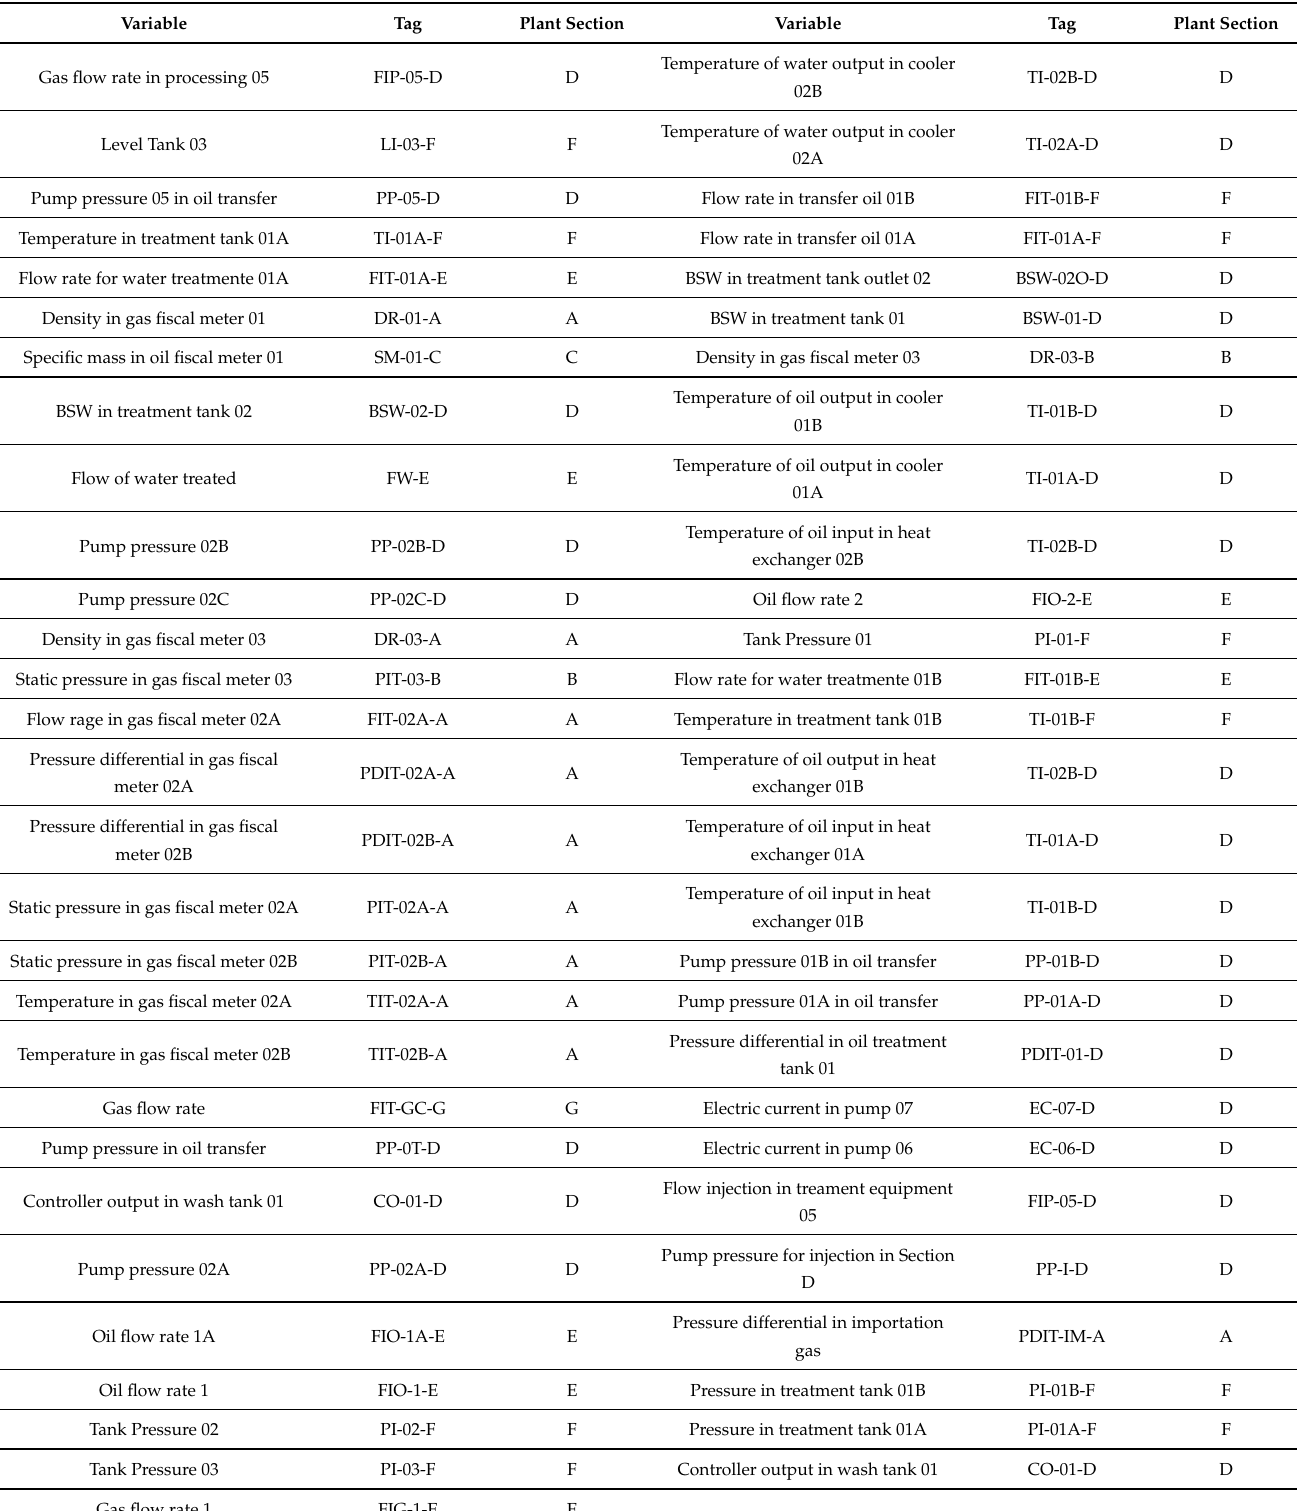
Table A3. Lisf of variables—Oil and gas fiscal metering